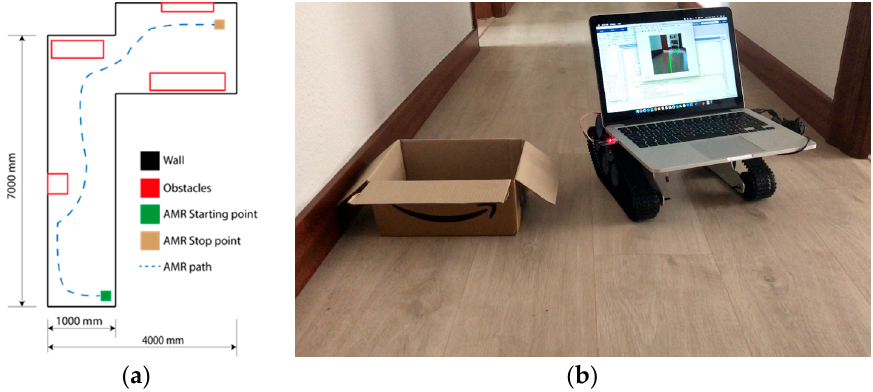
Figure 12. The first obstacle in the trajectory: ( a ) Illustration; ( b ) the real object in the scenario.